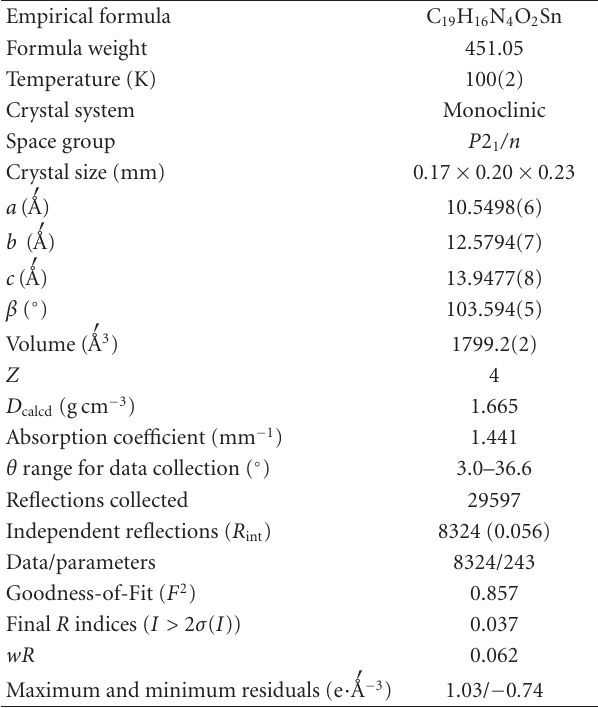
Table 1: X-ray crystal data and structure refinement for 2